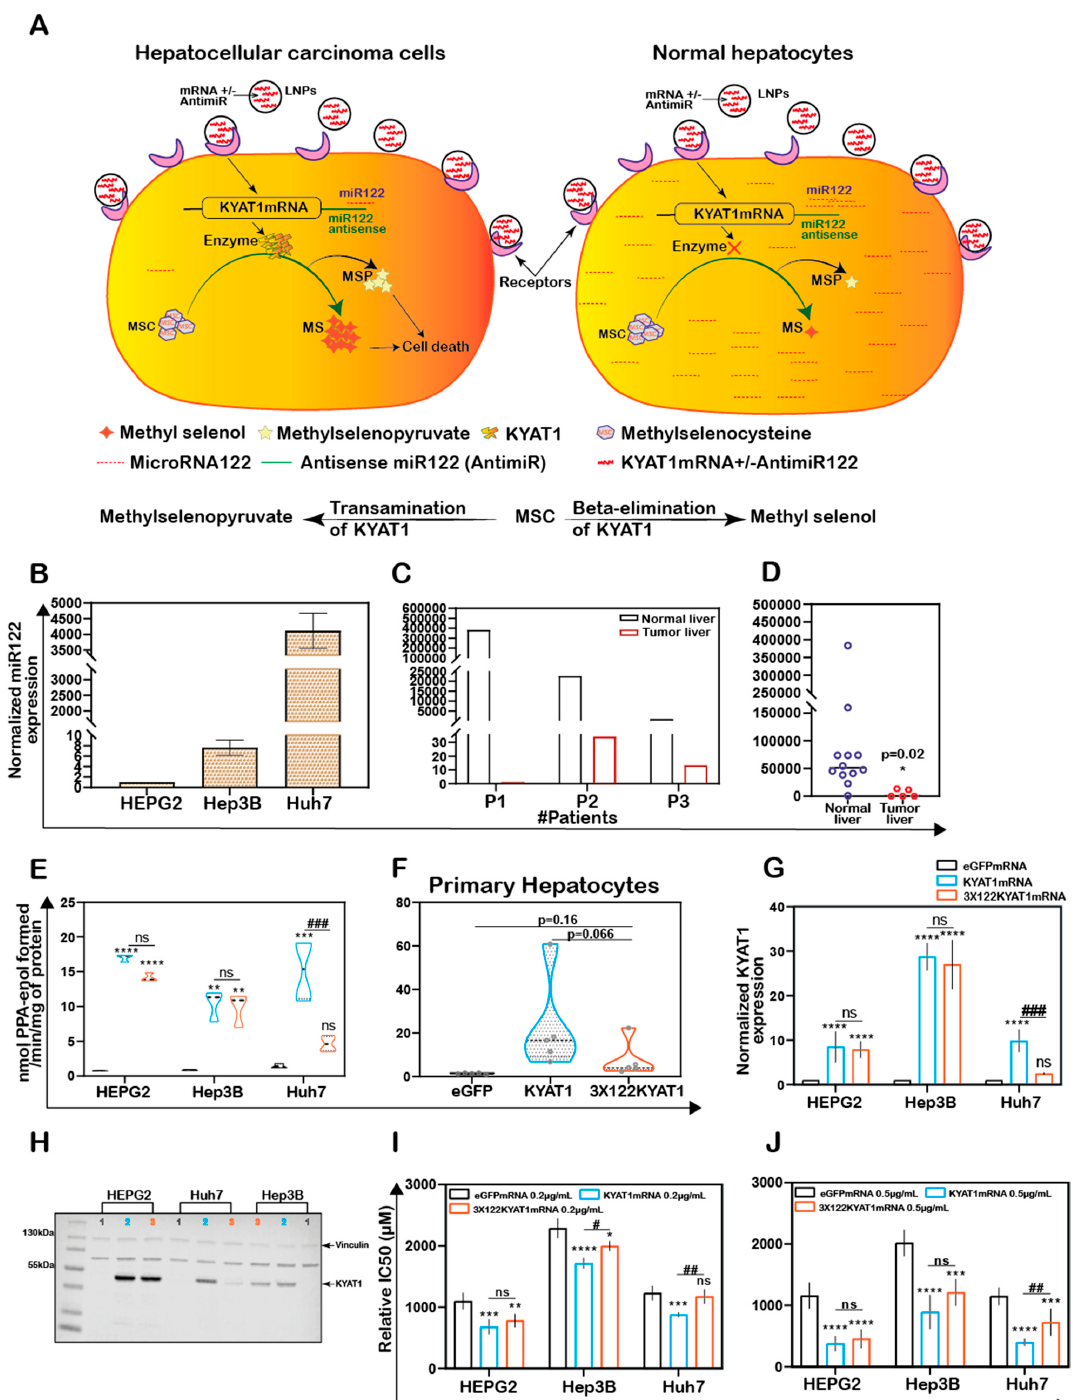
Figure 5. Endogenous expression of miRNA act as a targeted protein suppressor in cells transfected with mRNAs tagged with antisense miRNA target site. ( A ) Schematic representation of MicroRNA (miR122) assisted MSC metabolism via KYAT1 enzyme in cancer and normal hepatocytes. ( B ) Endogenous miR122 expression in HEPG2, Hep3B, and Huh7 cell lines by qRT-PCR ( n = 4). ( C ) miR122 expression in human primary HCC compared with surrounding “normal” primary-hepatocytes from three different patients ( n = 3). ( D ) Endogenous miR122 expression in freshly isolated healthy human hepatocytes ( n = 12) and human primary HCC ( n = 5). ( E ) Transamination activity of KYAT1 in cells transfected